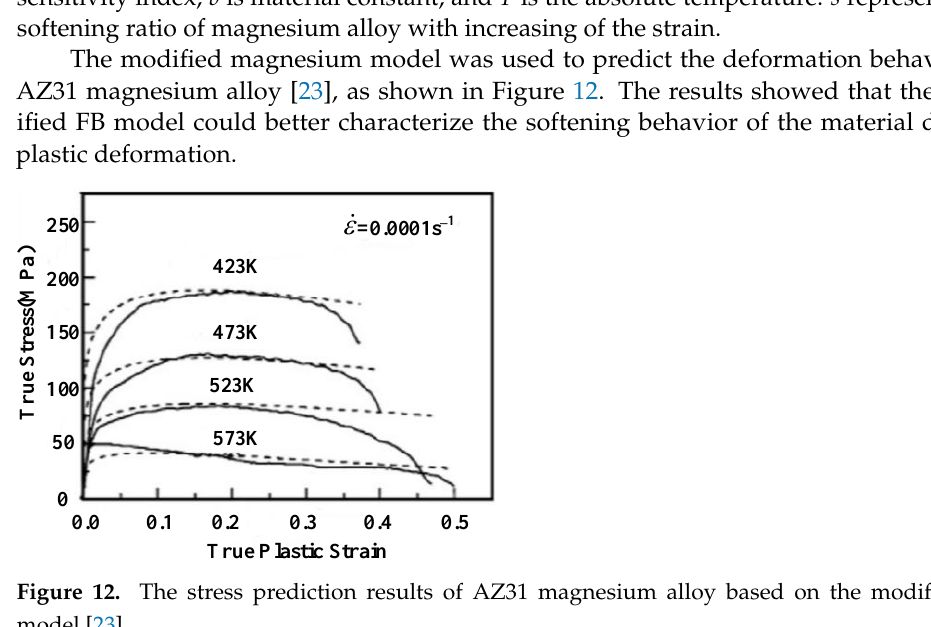
Figure 11. Flow stress curve of AZ31 magnesium alloy [23].